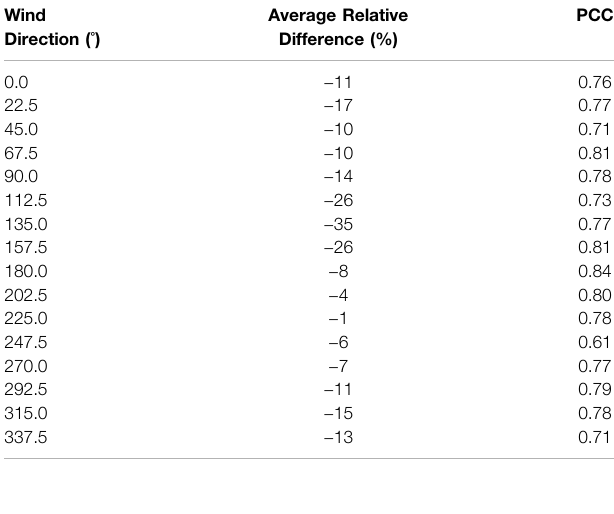
TABLE 5 | The average relative difference of wind velocity magnitude, and the Pearson correlation coef fi cient (PCC), between wind simulations and wind tunnel experiments for 16 wind directions at the 80